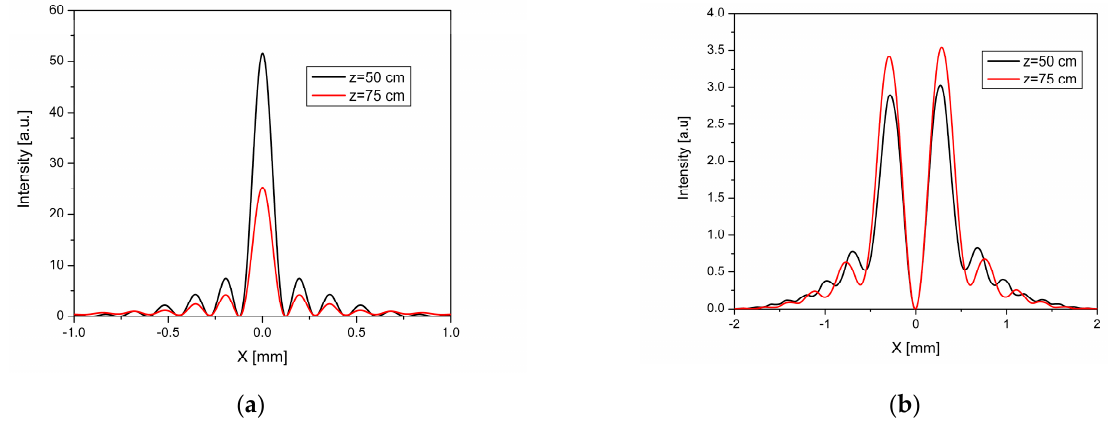
Figure 3. Intensity distribution in cross-section generated by: ( a ) zero-order axicon at z = 50 cm (black line) and z = 75 cm (red line), ( b ) spiral first-order axicon at z = 50 cm (black line) and z = 75 cm (red line).